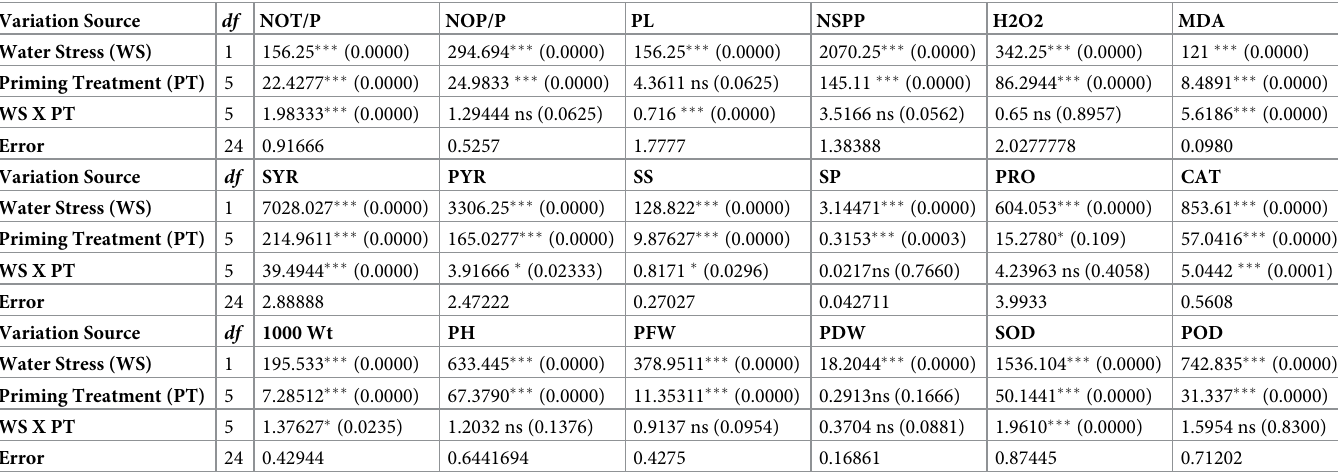
Table 2. Mean square and p values from the ANOVA of data obtained through ZnONPs application on rice